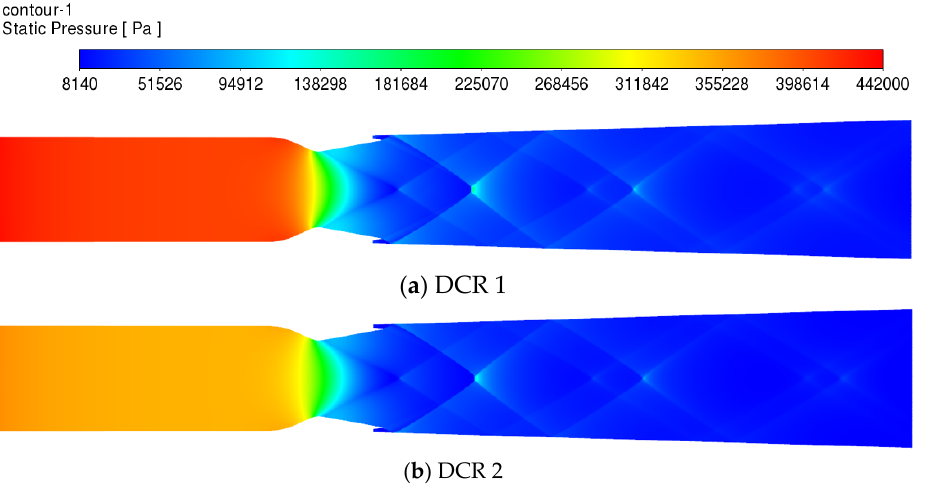
Figure 11. Static pressure contours for DCR 1 and DCR 2.